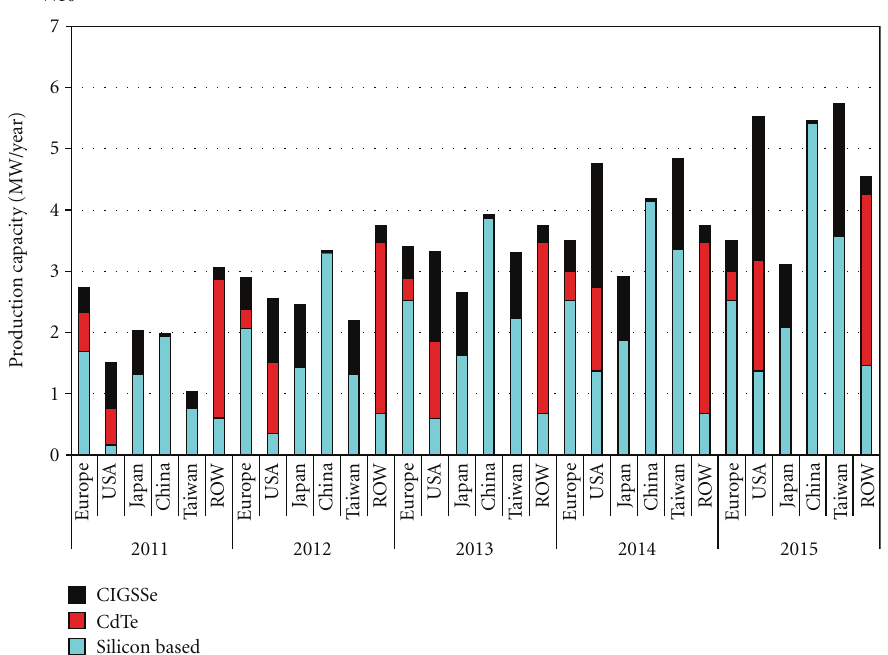
Figure 7: Projected thin film PV production capacities. Regional distribution of the di ff erent